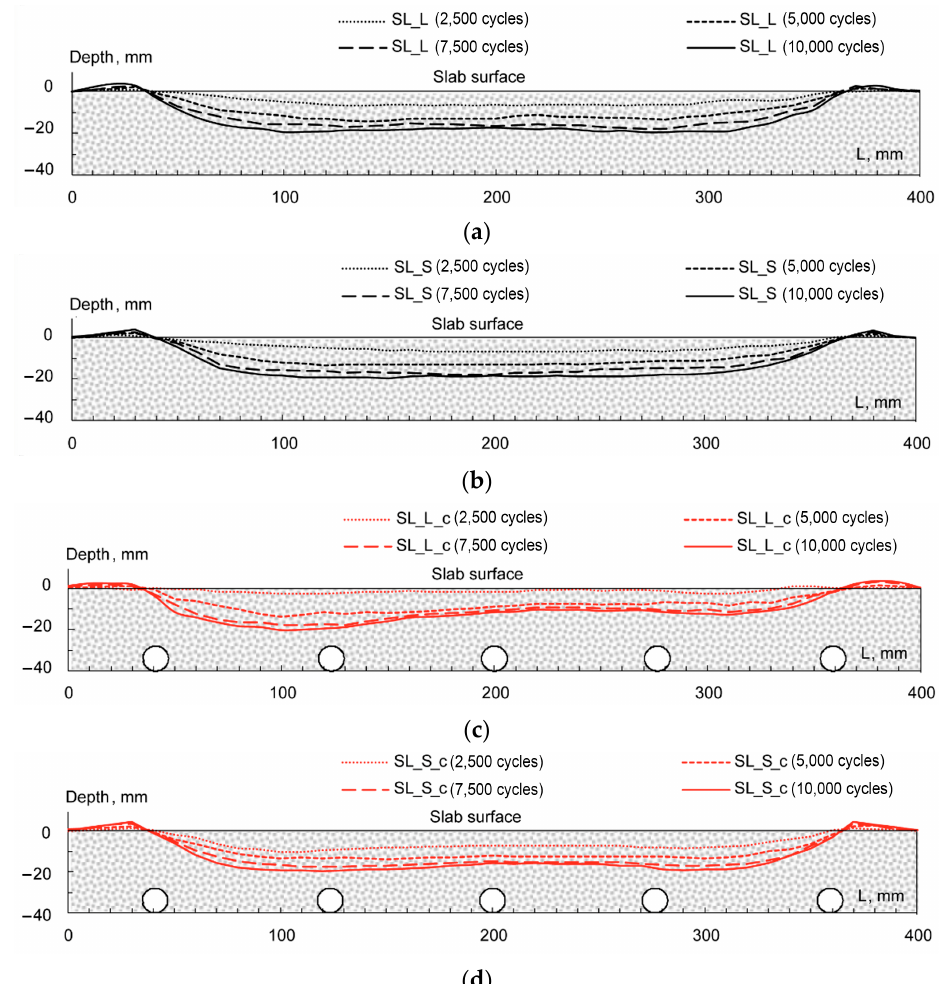
Figure 13. Rut profiles vs. loading cycles: SL_L ( a ), SL_S ( b ), SL_L_c ( c ), SL_S_c ( d ).